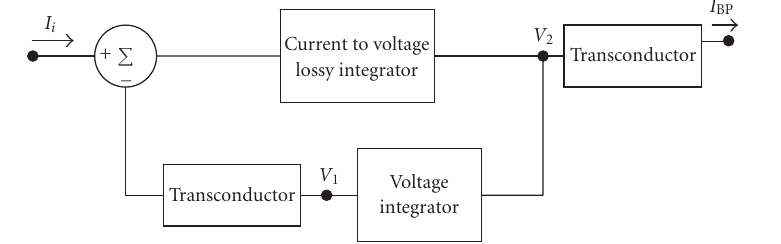
Figure 2: The block diagram of the proposed current-mode filter.